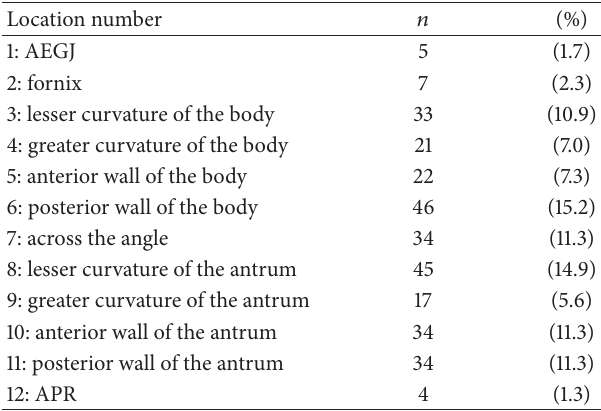
Table 2: Classification of lesions by location ( 𝑛 = 302